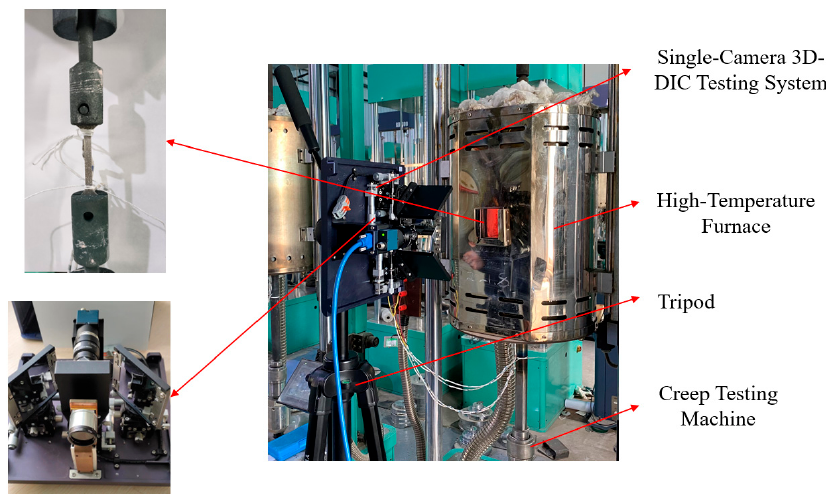
Figure 5. Creep test system based on 3D-DIC method.